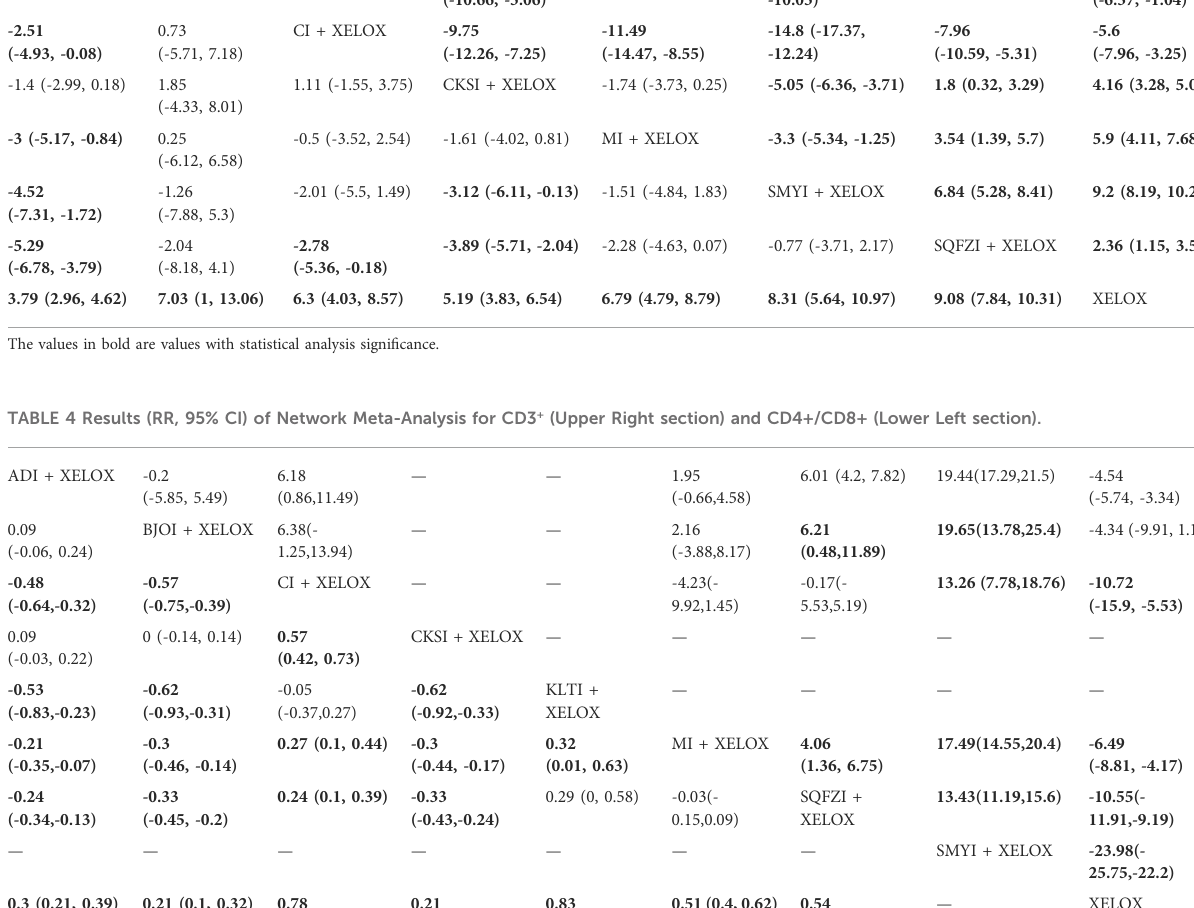
TABLE 3 Results (MD, 95% CI) of Network Meta-Analysis for CD8 + (Upper Rightsection) and CD4 + (Lower Left section). ADI + XELOX